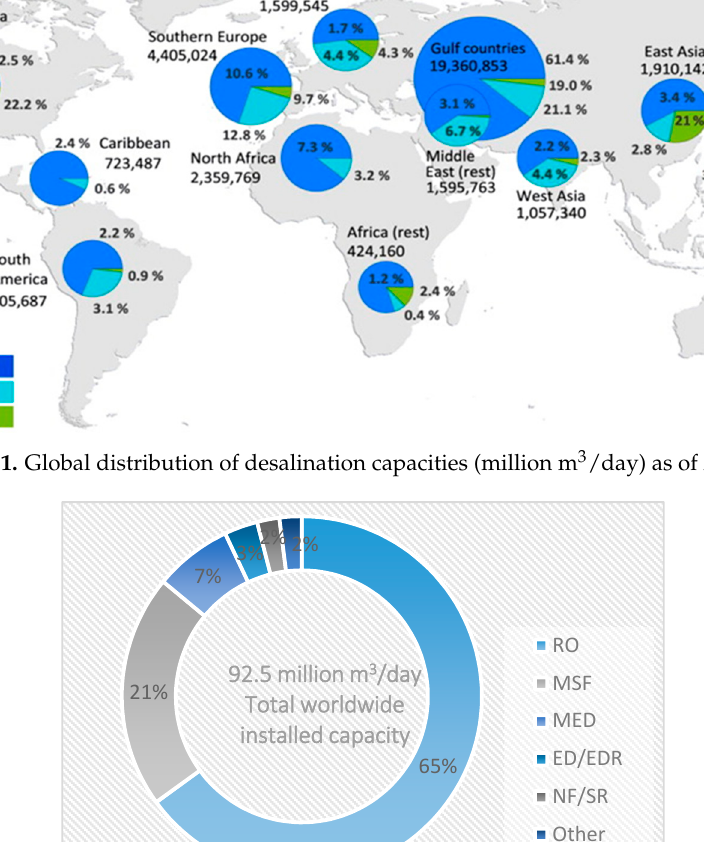
Figure 3. Total worldwide installed capacity by user type re-drawn from [26]. ( a ) Leading industries use desalination; ( b ) 28th Worldwide desalting plant inventory.